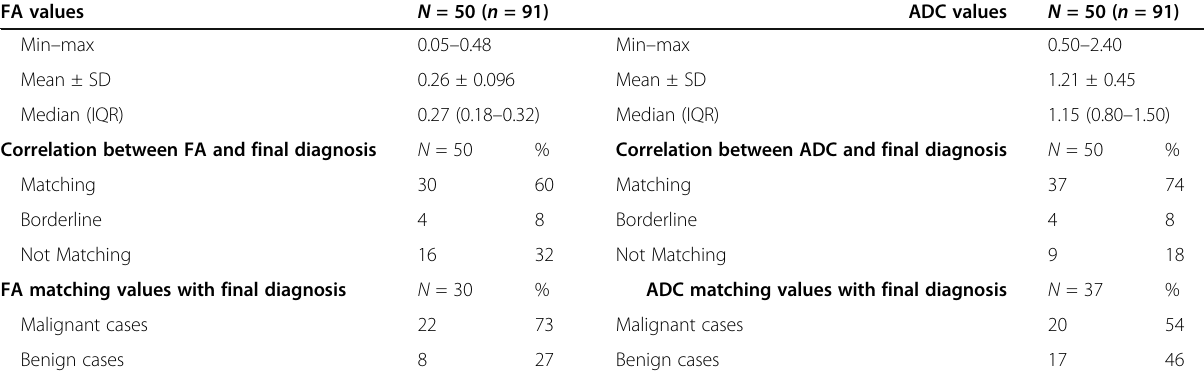
Table 5 Distribution of the studied cases according to FA and ADC in correlation to final diagnosis ( N = 50) FA